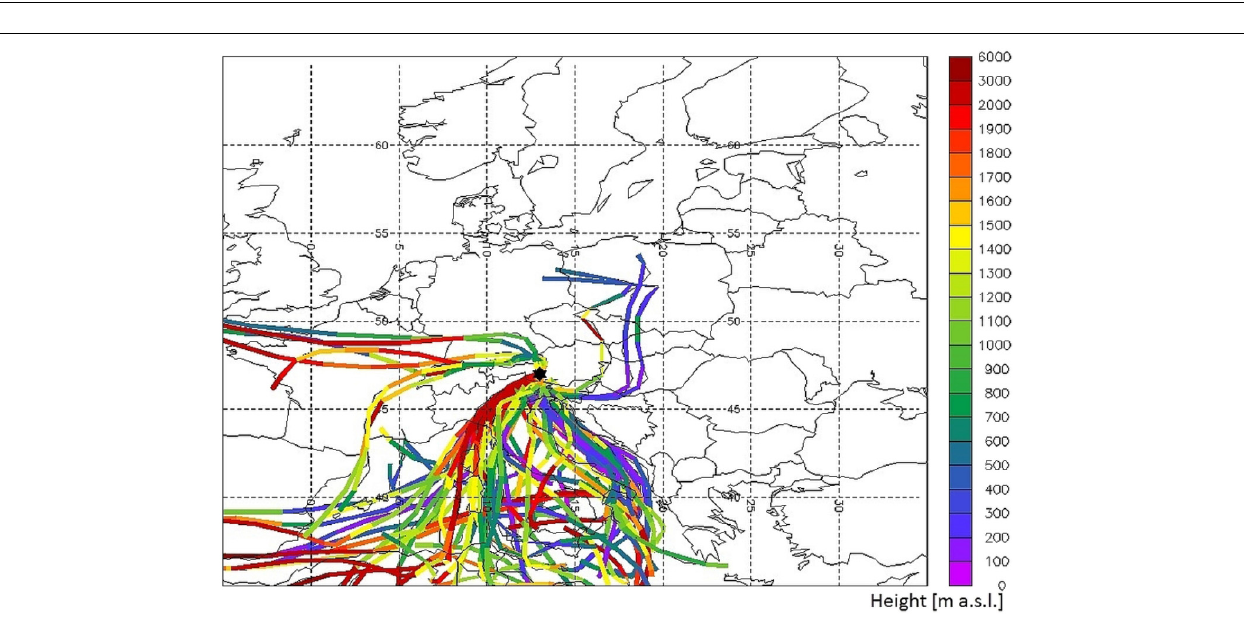
FIGURE 3 | Ninety-six hours backward trajectories starting from the Sonnblick Observatory every 3 h between 31 March 2016 00UTC and 8 April 2016 21UTC. Trajectories from the South reveal that Saharan dust occurrence at the sampling site during that time is very